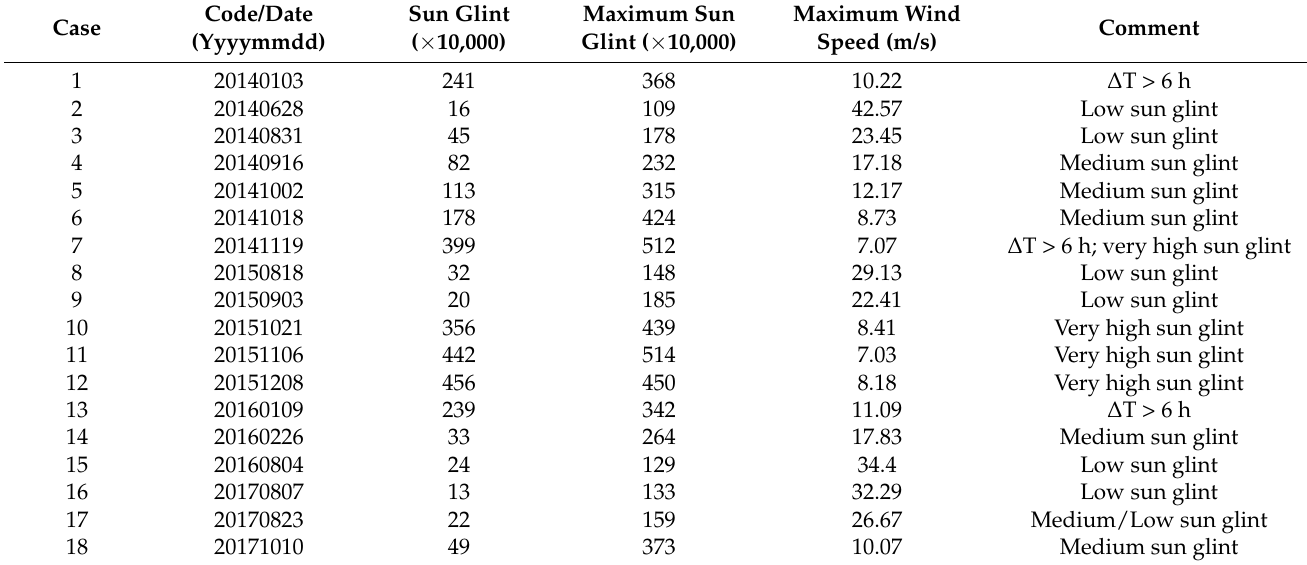
Table 4. Sun glint assessment for 18 Landsat 8 images covering the LJCO site, where ∆ T is the time difference between satellite overpass and in situ measurements (see Table